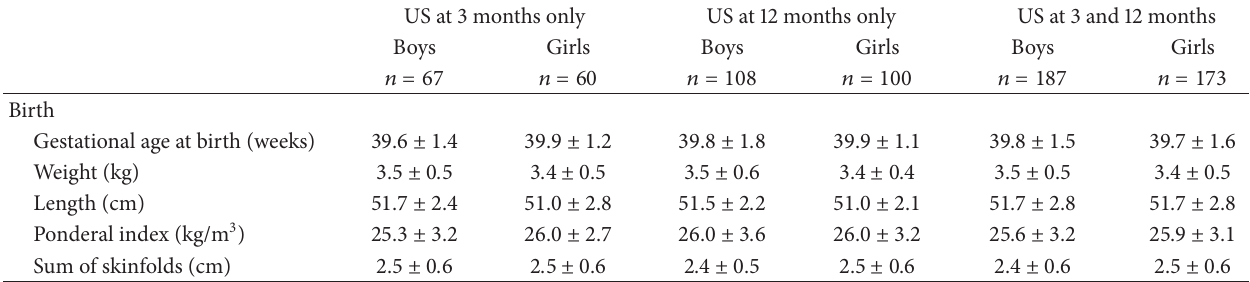
Table 1: Infants characteristics in the Cambridge Baby Growth Study with ultrasound measures at 3 months, 12 months and both at 3 and 12 months 1